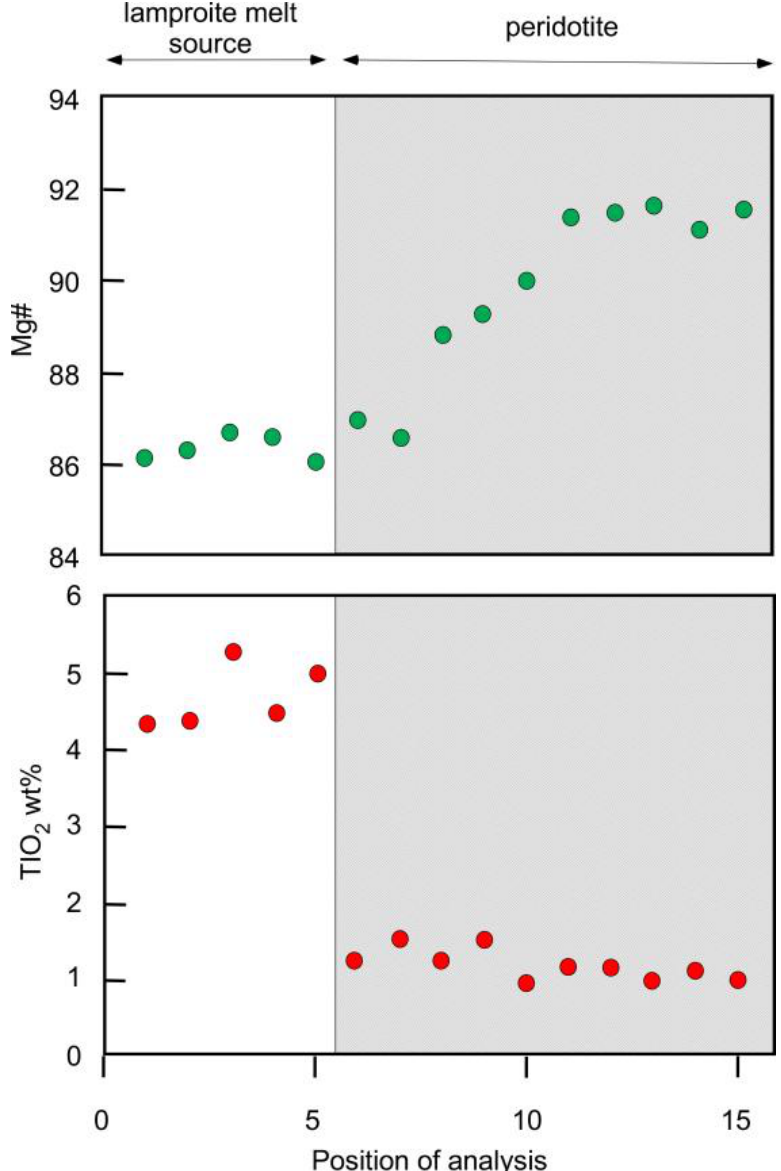
Figure 4. Traverse of phlogopite compositions in lamproite and peridotite sections of Experiment G131 (3 GPa, 1100 °C), plotted from bottom to top of capsule (left to right). Trends are similar to those in Figure 3 but the lamproite characteristics are beginning to dominate the Mg# at the start of the peridotite section, probably due to the higher proportion of lamproite in this